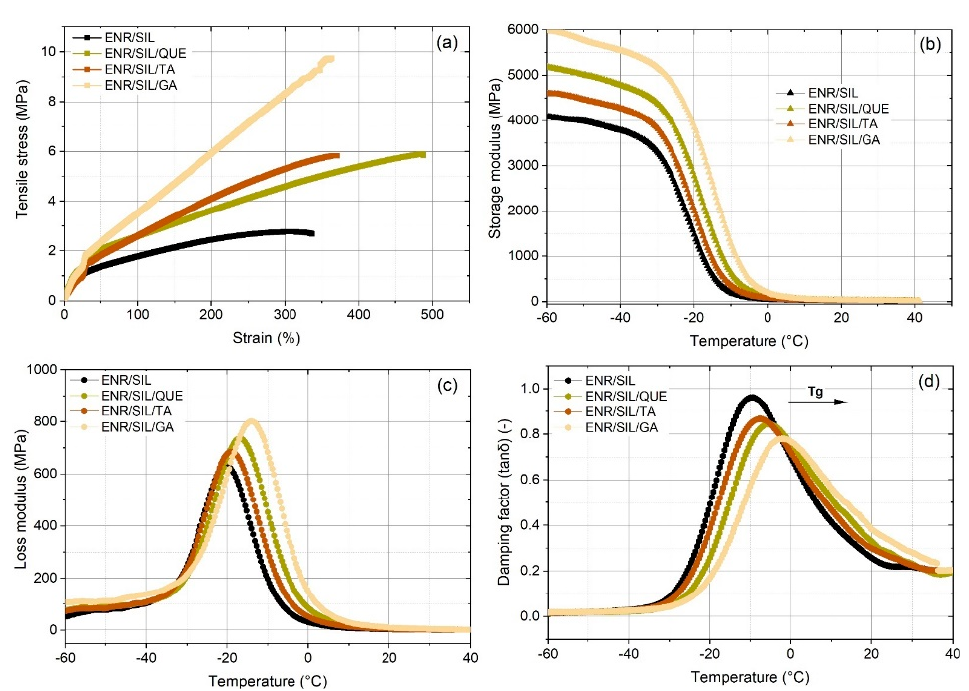
Figure 4. The selected strain-stress curves of tested ENR/silica composites with natural phenolic compounds obtained from static mechanical analysis ( a ), storage modulus results ( b ), loss modulus results ( c ), and damping factor ( d ) of the same composites obtained from dynamic mechanical analysis (DMA). Dynamic mechanical thermal analysis was useful for observing the changes in three parameters as a function of temperature: storage modulus (E’) related to stored energy and representing the elastic portion, loss modulus (E”) referred to the energy dissipated as heat, which corresponded to the viscous portion. Additionally, the damping factor (tan δ ) was also observed. The damping factor is defined as tan δ = E”/E’ and indicates the energy dissipation of a material along with enabling the detection of the glass transition temperature (Tg). In this research, the glass transition temperature was detected as a tem- perature at a maximum damping factor (tan δ ). All curves belonging to the tested ENR/SIL composites with natural phenolic compounds are presented in Figure 4b–d as well as in Table 3. As shown in Figure 4b, in the range of − 60 °C to 20 °C, considerable changes between tested composites are revealed. It was noticed that the storage modulus (E’) of the pure ENR/SIL composite and composites with natural phenolic compounds was found to decrease as a function of temperature because of the softening of the polymer chains with the temperature. The raised storage modulus for the ENR/silica composites containing natural phenolic compounds occurred particularly in the case of ENR/SIL/GA due to the reinforcement and the mobility restriction as a result of a crosslinking effect. Moreover, aromatic rings, which belong to natural phenolic compounds are rigid and might contribute to the whole material stiffening. Natural phenolic compounds also caused the material’s glass transition temperature increase f rom − 9.7 °C to − 7.7 °C in the case of tannic acid, to − 5.4 °C after adding quercetin and to − 1.9 °C due to gallic acid. Such a phenomenon also confirmed the stiffening effect of the ENR/SIL material.